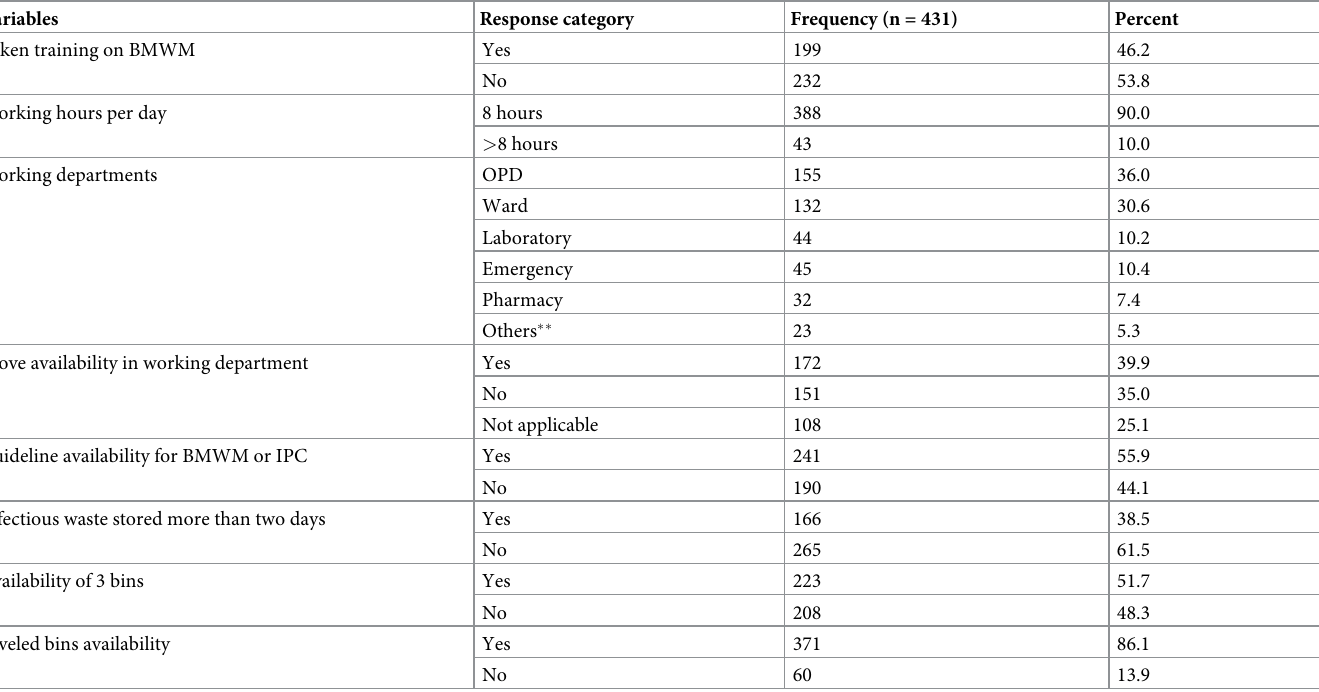
Table 2. HCF related factors for BMWM among HCWs at metropolitan cities private hospitals of Amhara region, Ethiopia, 2020.